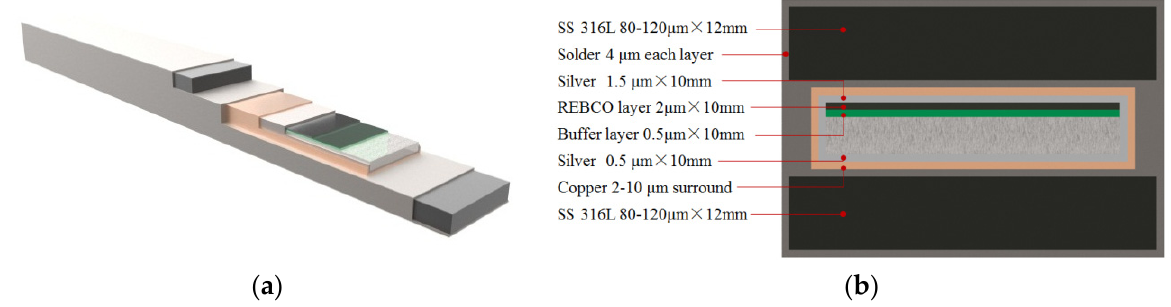
Figure 1. ( a ) Cross-section of laminated tape used for SFCL; ( b ) cross-sectional area of each material. When not in a superconducting state, the superconductor layer and the buffer layers are considered as oxide materials, with electrical resistance much higher than metals. Hence, their resistances were excluded in resistance calculation. The resistance of every metal layer can be calculated using the formula below.